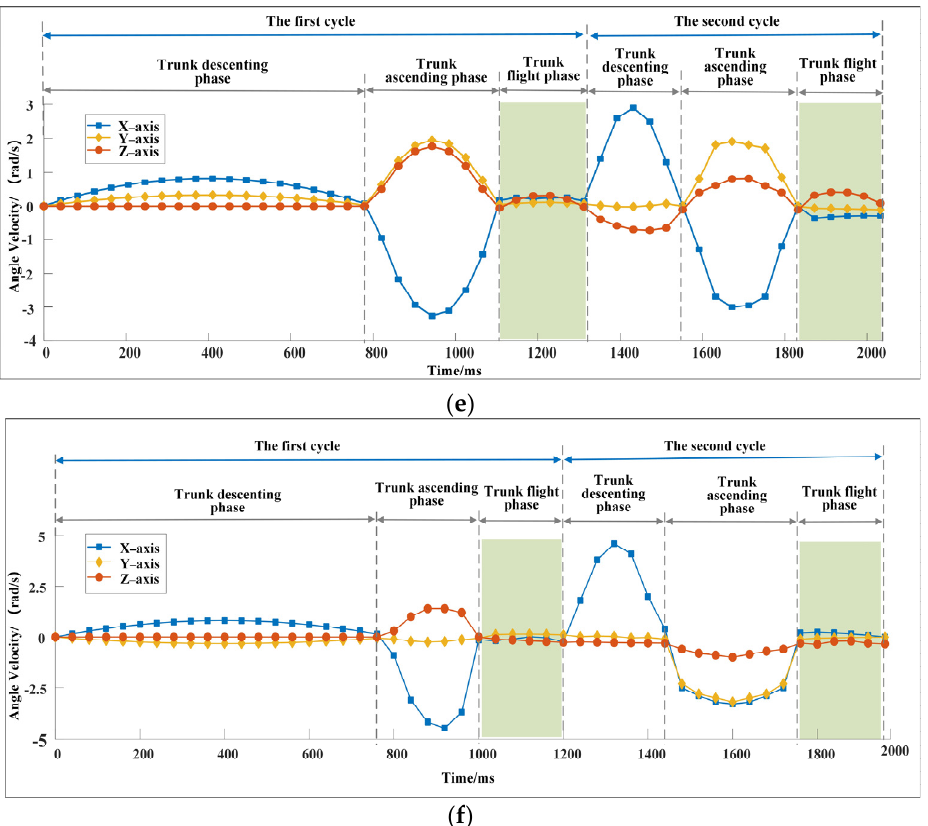
Figure 6. ( a ) Top view of the motion sequences of the robot for simulation example 1. The robot rotates 28.08 ◦ around the vertical axis in both cycles, and the direction of motion changes considerably. ( b ) Top view of the motion sequences of the robot for simulation example 2. The robot rotates − 28.28 ◦ around the vertical axis in both cycles. ( c ) Change of trunk posture for simulation example 1. The changes of the maximum rotation angles of the trunk in the flight phase are − 2.95 ◦ , 3.75 ◦ , and 3.32 ◦ . ( d ) The change of trunk posture for simulation example 2. The changes of the maximum rotation angles of the trunk in the flight phase are 1.88 ◦ , 0.92 ◦ , and − 3.72 ◦ . ( e ) Change of trunk angular velocity of the trunk for simulation example 1. ( f ) Change of trunk angular velocity of the trunk for simulation example 2.